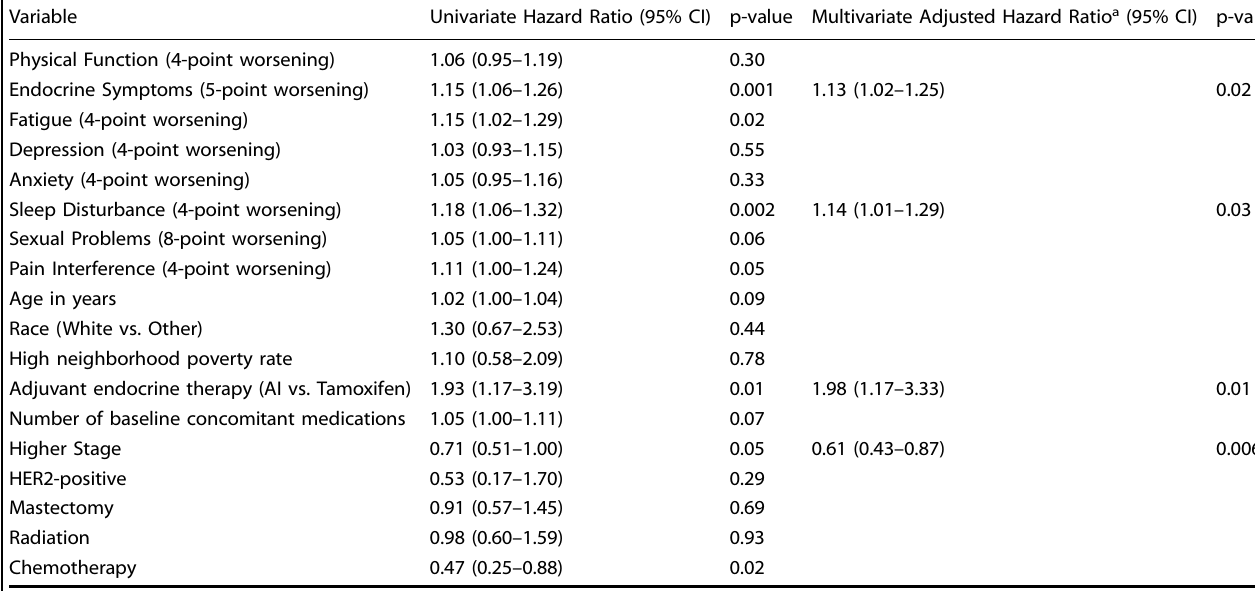
Table 5. Univariate and multivariate associations of new or worsening symptoms and clinico-demographic variables with time to discontinuation of adjuvant endocrine